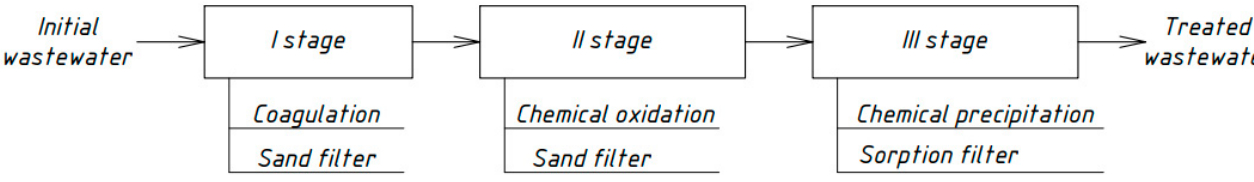
Figure 1. Scheme of the laboratory modeling processes.